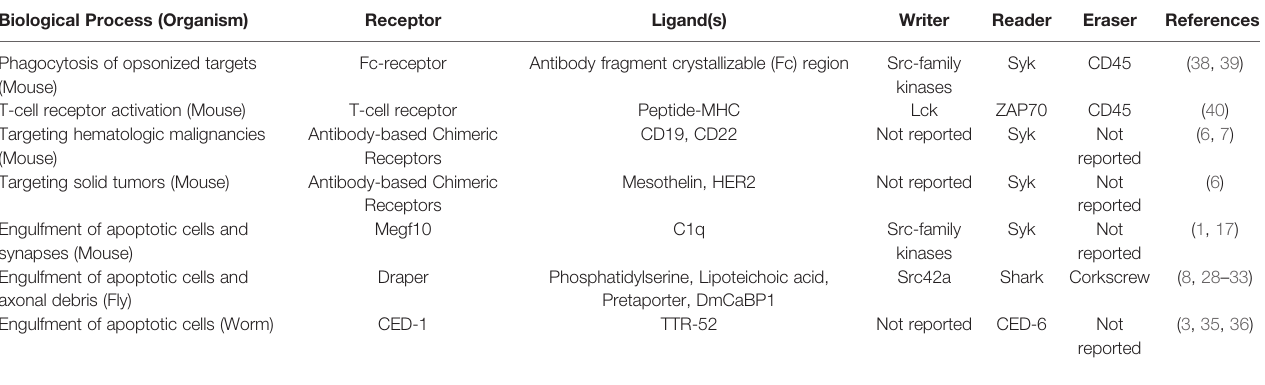
TABLE 1 | Summary of receptors and writer-reader-eraser modules used across biological processes and organisms. Biological Process (Organism) Receptor